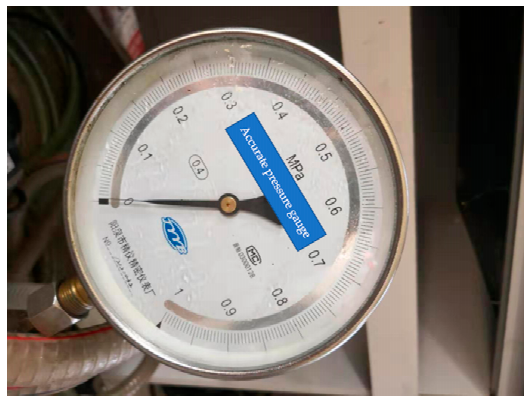
Figure 7. Pressure gauge.